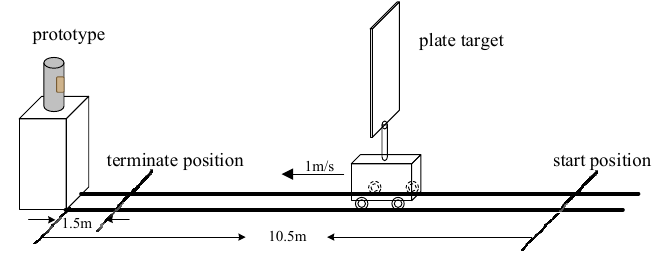
Figure 9. The scenario of a low speed encounter for prototype in the chamber (the metal plate target was fixed on the moving car vertically, and the prototype was placed at one end of the track, loaded by the car moving along the track from 10.5 to 1.5 m at a speed of 1 m/s).